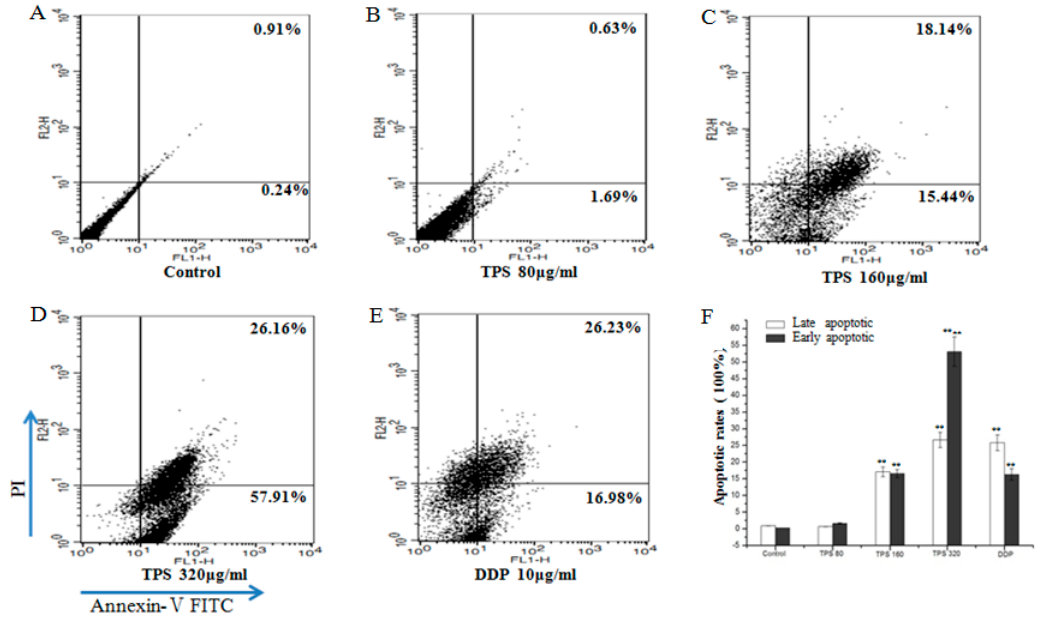
Figure 8. TPS inhibited cell cycle in CT26 cells. Cell cycle progression of the control group, TPS group at indicated concentrations and positive control group DDP cells for 48 h were determined by FACS analysis ( A – E ). ( F ) Bar graphs show mean ± SD of three independent experiments. * p < 0.05, ** p < 0.01, vs. control group. Δ p < 0.01, ΔΔ p < 0.01 vs. DDP group.